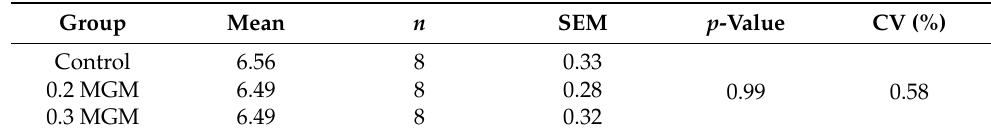
Table 2. Experimental animal